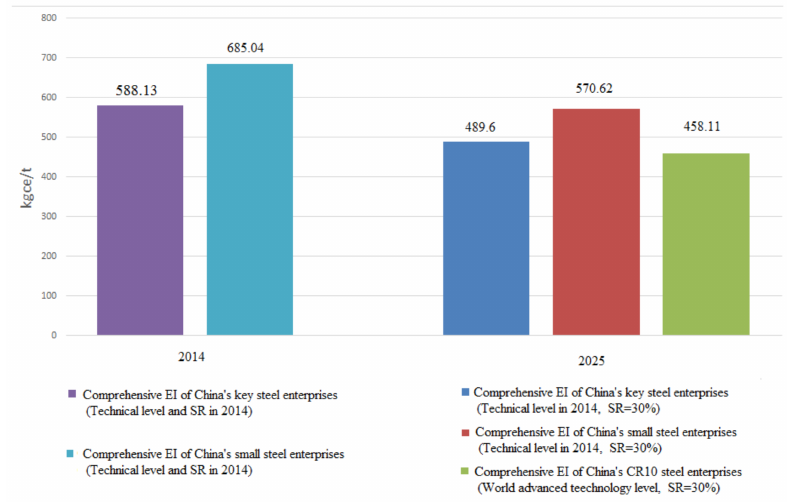
Figure 2. EI of different scale steel enterprises in China in 2014 and